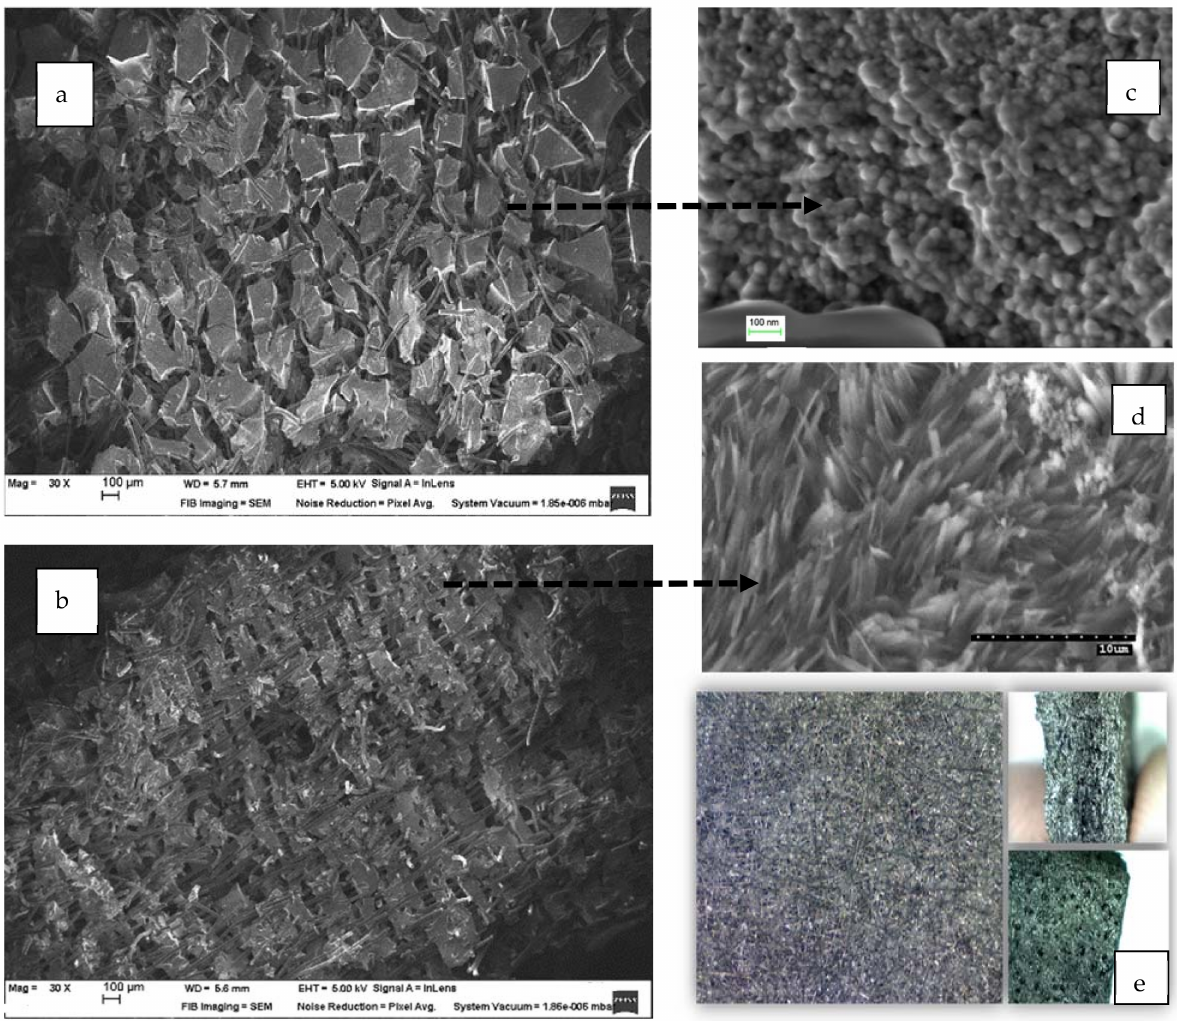
Figure 9. Various morphologies of CX: ( a , c ) scanning electron microscopy of the CX electrode X2 variant; ( b , d ) scanning electron microscopy of CX type nanowhiskers electrode—X4 variant; ( e ) optical micrograph of the electrode surface ×